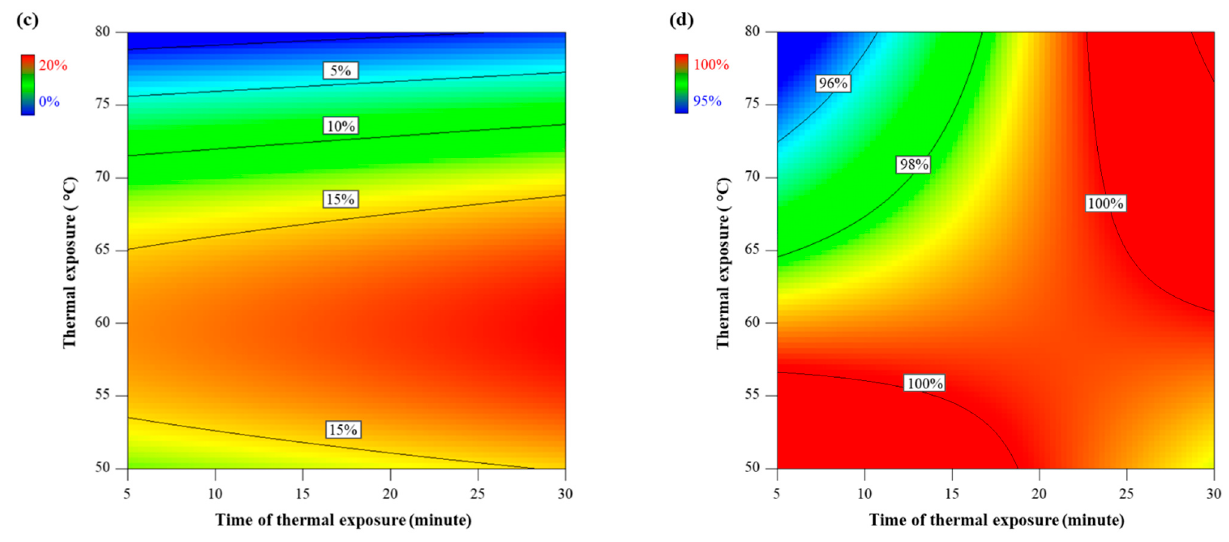
Figure 3. Effects of mild thermal exposure (50–80 °C) for extended times of thermal exposure (5–30 min). Contour plots of dry weight ( a ), percent successful completion of molt to 2nd instar ( b ) and percent successful completion of molt to 3rd instar ( c ), and percent survival ( d ). Western corn rootworm larvae were reared on WCRMO-2 diet for 10 days. Color bars display the magnitude of the measured responses.